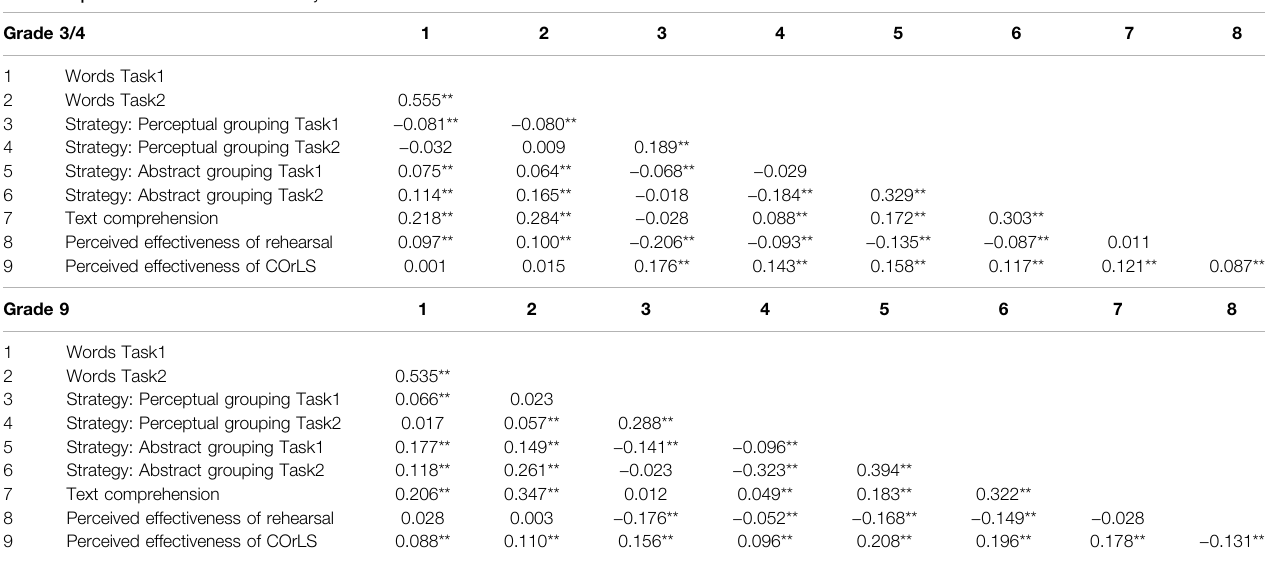
TABLE 2 | Correlations between All Study Variables for Grades 3/4 and